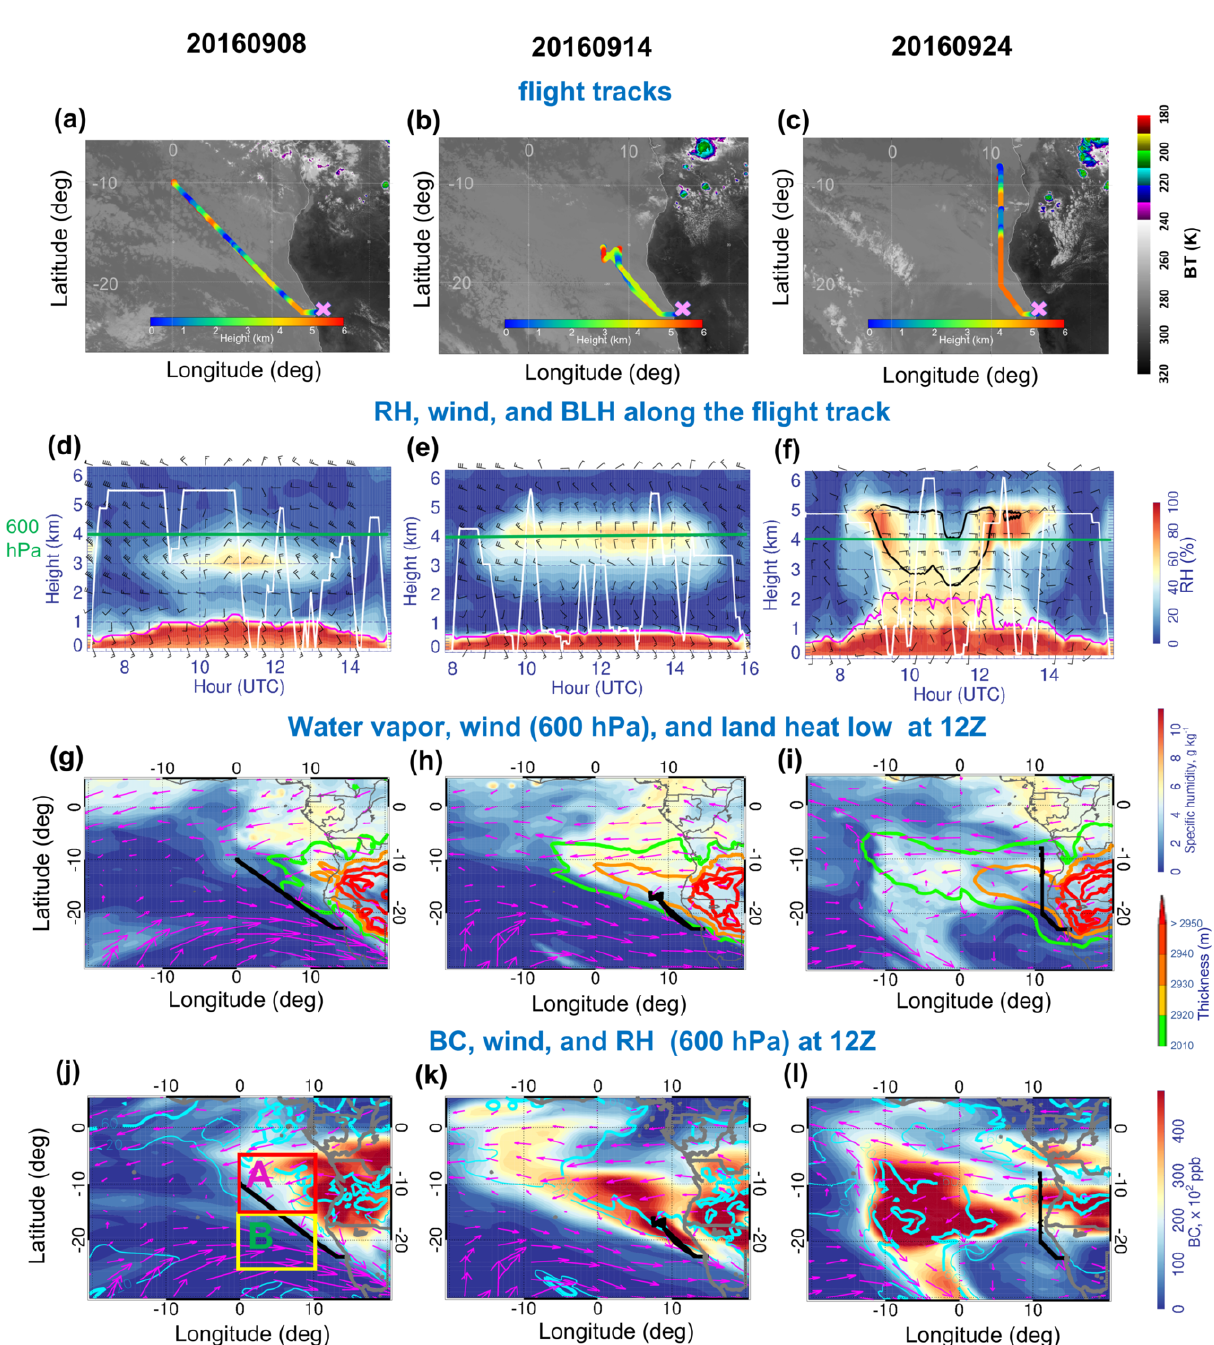
Figure 3. (a–c) The horizontal flight tracks during September 2016 ORACLES deployment plotted on the Meteosat IR 10.8µm imagery at 13:45UTC (shading is brightness temperature (BT); K). The color of the flight track represents the altitude of the P-3 flight along the horizontal flight track. (d–f) Curtain plot of RH along the P-3 flight track during 8, 14, and 24 September 2016. The white contour represents the flight profile. The magenta line in panels (d) – (f) represents the BLH along the flight track. Bold black contours in panels (d) – (f) indicate the zonal wind isotach of − 8ms − 1 . The green line in panels (d) – (f) indicates the 600hPa level. (g–i) Map of 600hPa specific humidity ( q ; color shading; gkg − 1 ) and 600hPa horizontal winds (vectors; ms − 1 ) overlaid by thickness (thickness is the geopotential height ( Z ) difference between 600 and 850hPa; color line contour; high values ( > 2920m) over land represents the heat low) at 12:00UTC on 8, 14, and 24 September 2016, respectively. (j–l) Map of 600hPa BC (shading; ppb × 100) overlaid by 600hPa RH (thick cyan line is 60; thin cyan line is 20; %) and 600hPa horizontal winds (vectors; ms − 1 ) at 12:00UTC on 8, 14, and 24 September 2016. The black line in panels (g) – (l) represents the horizontal flight track on the given day. The magenta (yellow) box in panel (j) refers to region A at 0–10 ◦ E, 5–15 ◦ S (region B at 0–10 ◦ E, 15–25 ◦